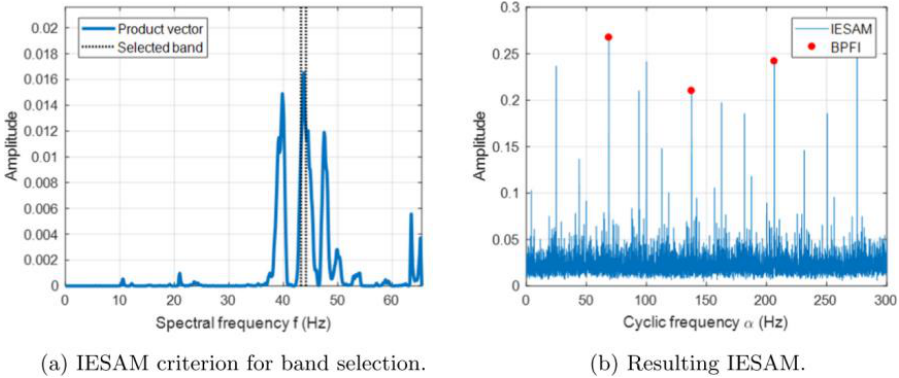
Figure 1. IESAM method applied to inner race fault with load 50 Nm. IESAM denotes improved envelope spectrum by alpha maximization.